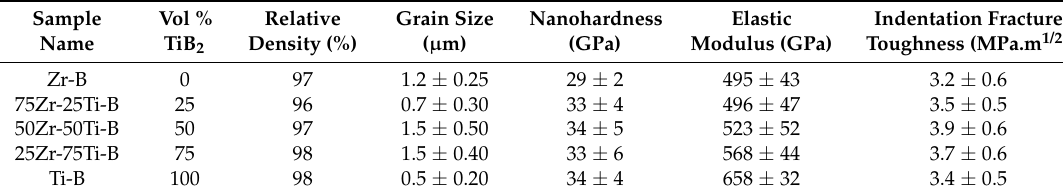
Table 1. Microstructural details and mechanical properties of reaction spark plasma sintered